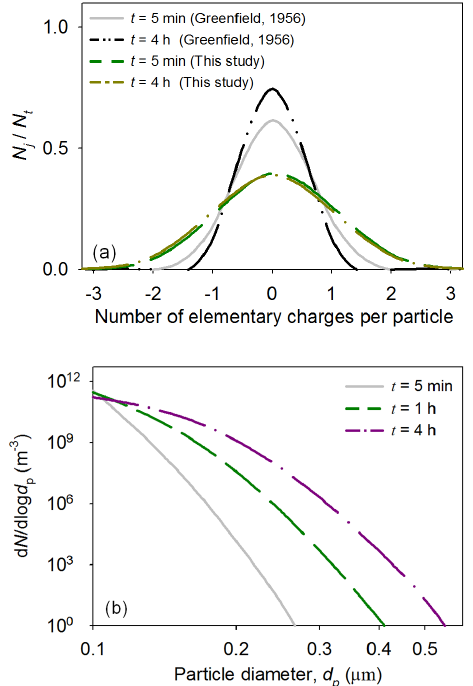
Figure 12. Time evolution of the charge (a) and size (b) dis- tributions of monodispersed radioactive particles at 6km altitude ( d p = 0 . 1µm, N t = 3 . 55 × 10 10 m − 3 ; I = 1 . 5 × 10 4 s − 1 , where I is the ionization rate coefficient of beta-emitting radionuclides). Ap- proach 1 was used to simultaneously simulate surface charging and coagulation of radioactive